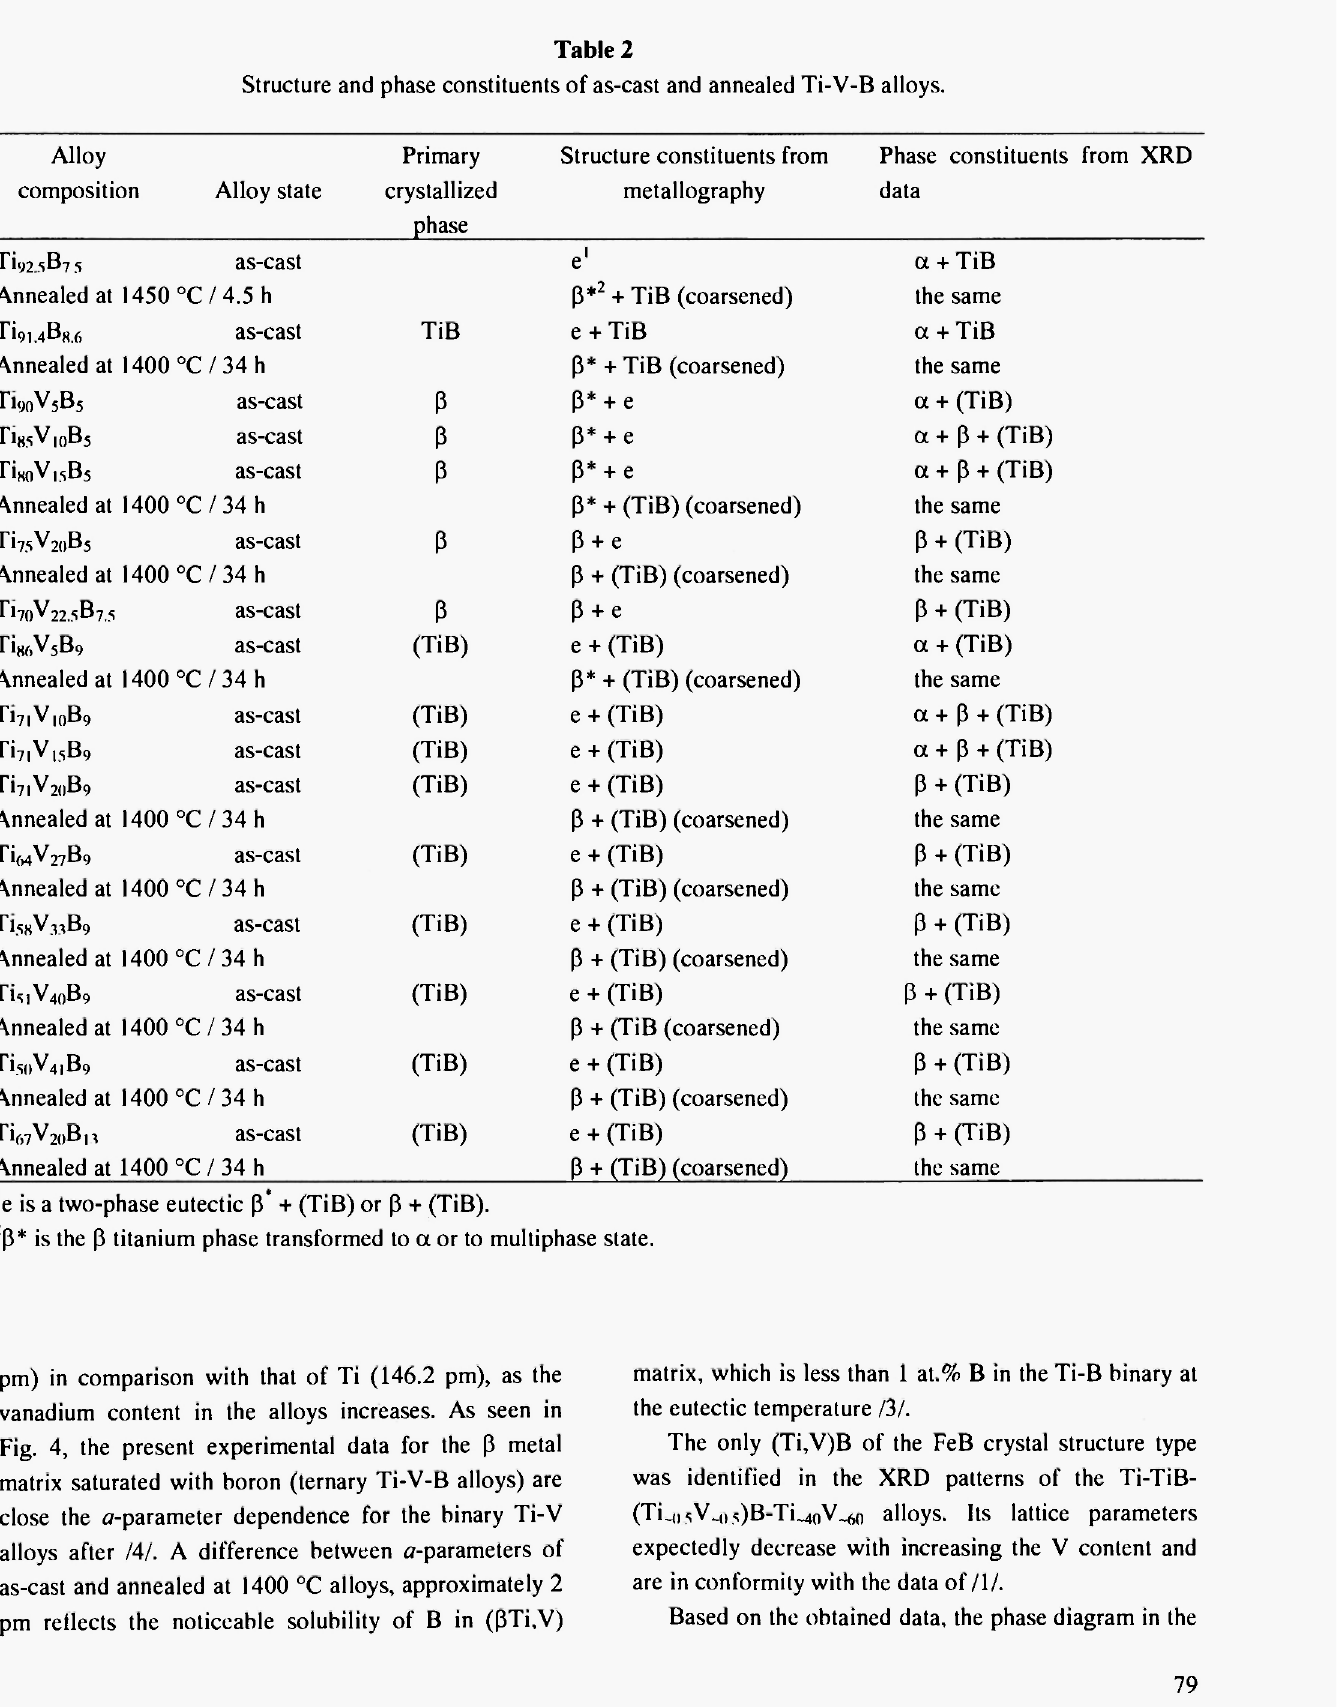
matrix, which is less than 1 at.% Β in the Ti-B binary at the eutectic temperature